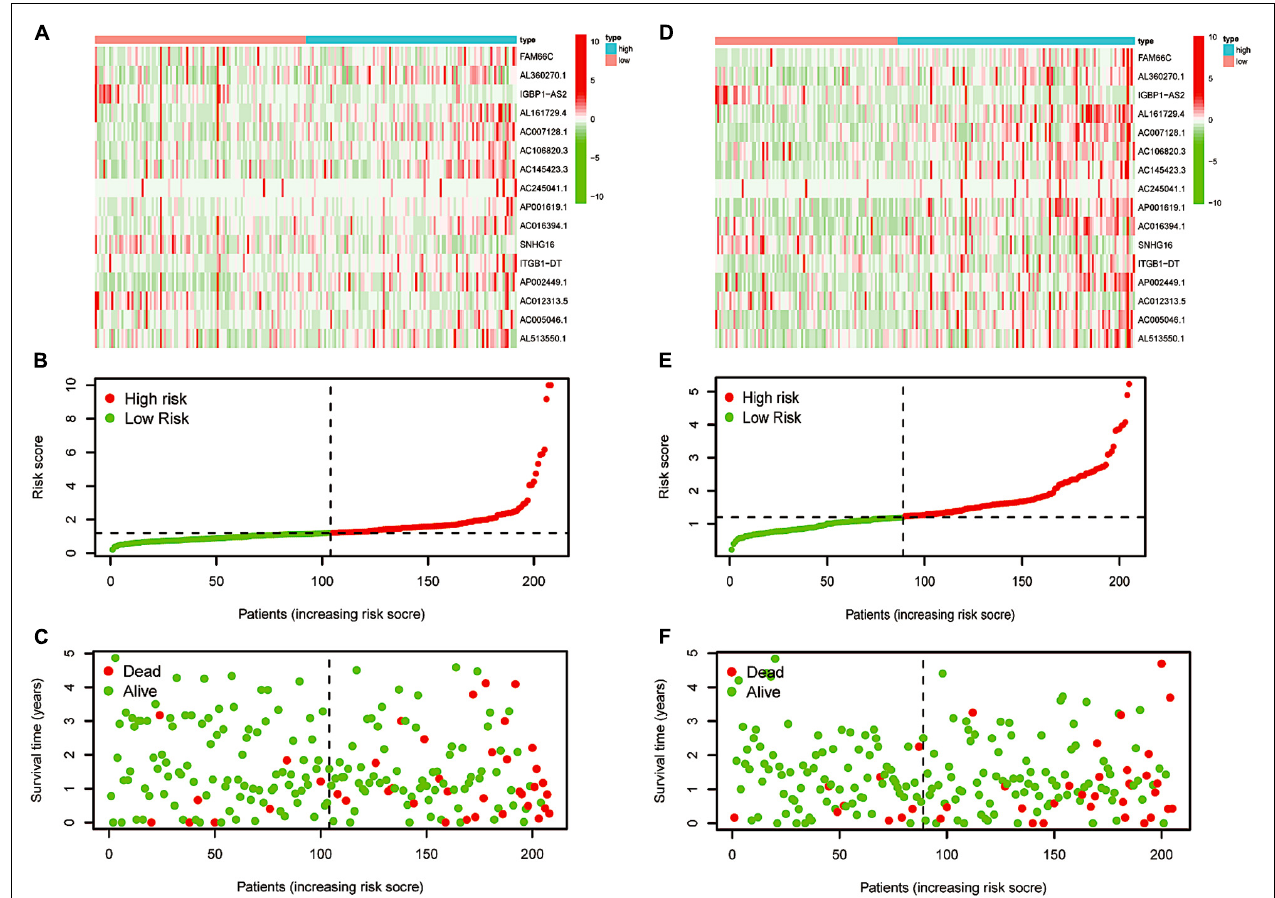
FIGURE 6 | Re-verification of the prognostic model. (A) Distributions of risk scores of CRC patients in the training group. (B,C) Heatmap of the relationship between lncRNAs composed of the prognostic model and risk scores and that between lncRNAs composed of the prognostic model and survival status in the training group. (D) Distributions of the risk scores of CRC patients in the testing group. (E,F) Heatmap of the relationship between lncRNAs composed of the prognostic model and risk scores and that between lncRNAs composed of the prognostic model and survival status in the testing group.